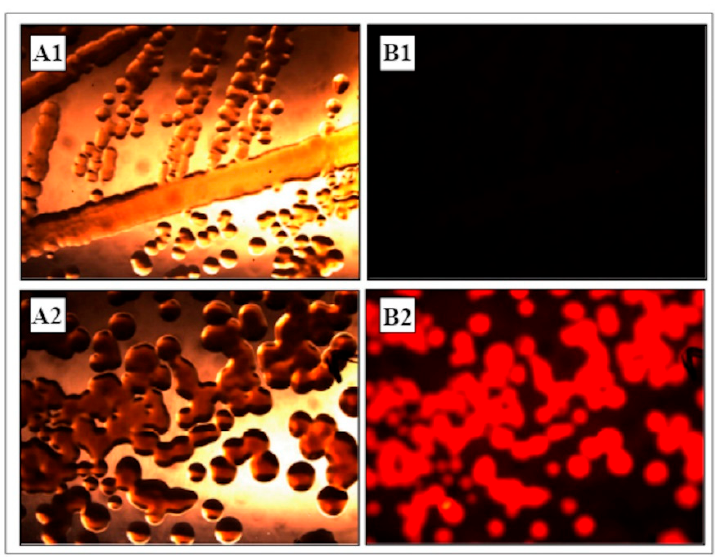
Figure 1. ( A ) Colonies of Pseudomonas protegens MP12 and ( B ) dsRed-tagged MP12 strain observed under a stereo microscopy by using (1) white light and (2) fluorescent light.